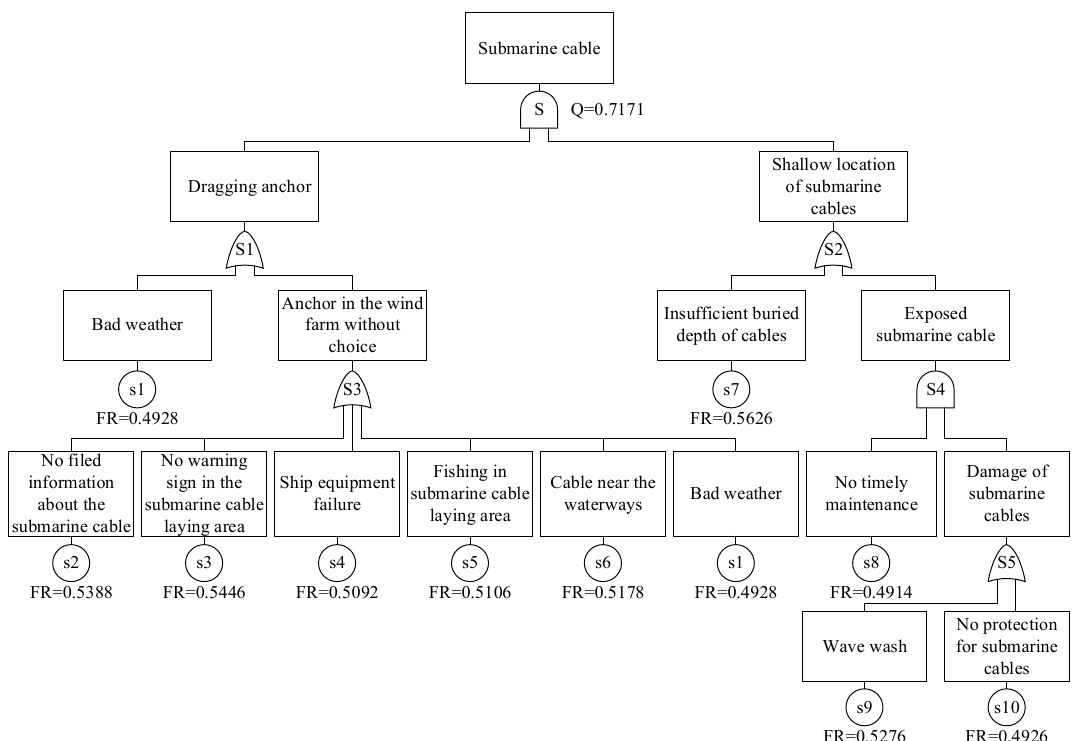
Figure 15. Fault tree analysis model for submarine cable risk of the offshore wind farm.